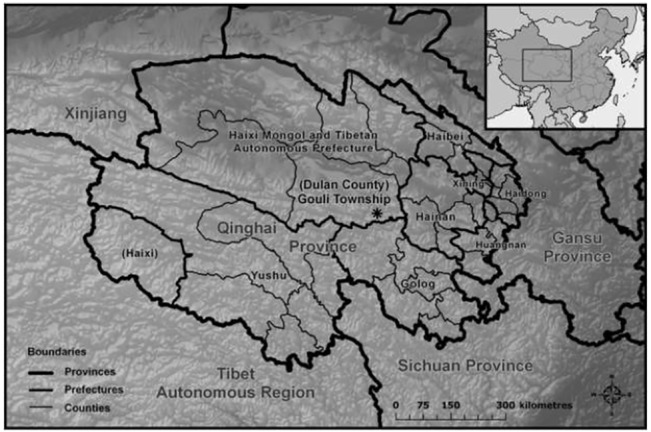
Map of Qinghai Province, China.Provincial boundary indicated by bold line, county boundaries by fine lines, and the location of Gouli Township within Dulan County with an asterisk (*). Inset shows location of Qinghai Province within the People’s Republic of China.